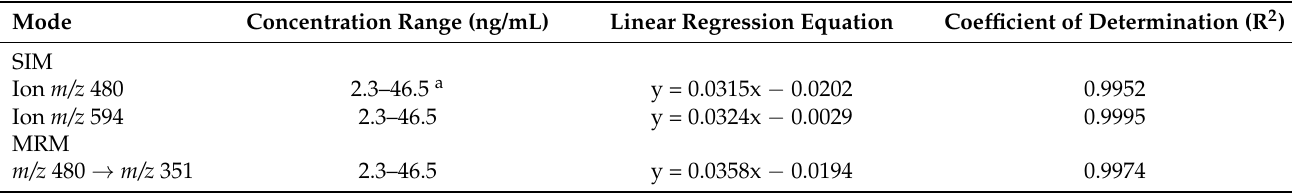
Table 2. Linearity in SIM and MRM modes.